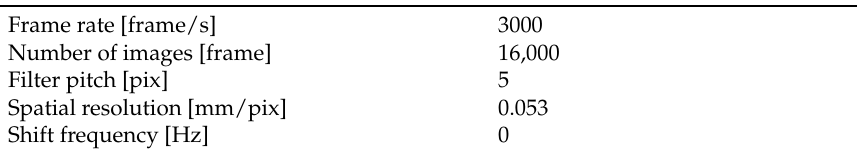
Table 1. Experimental conditions of SFV at inlet area.